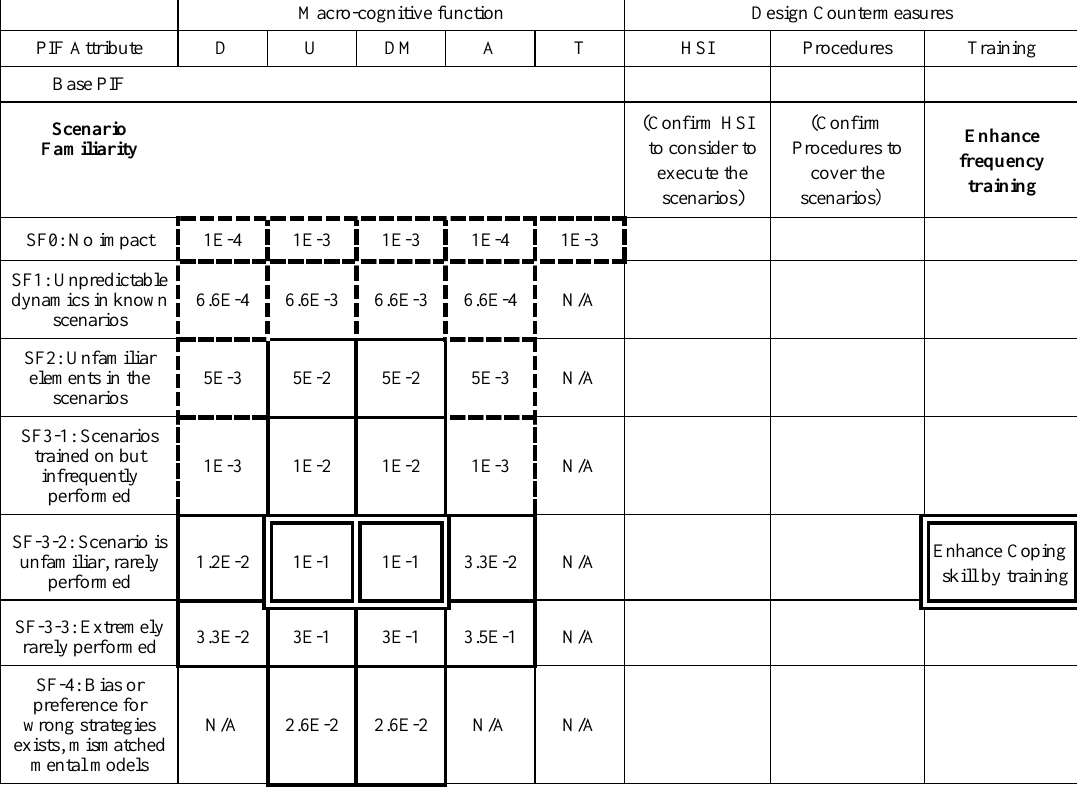
Table 1. PIFs/Design countermeasures comparison matrix (U.S.NRC, 2020). Macro-cognitive function Design